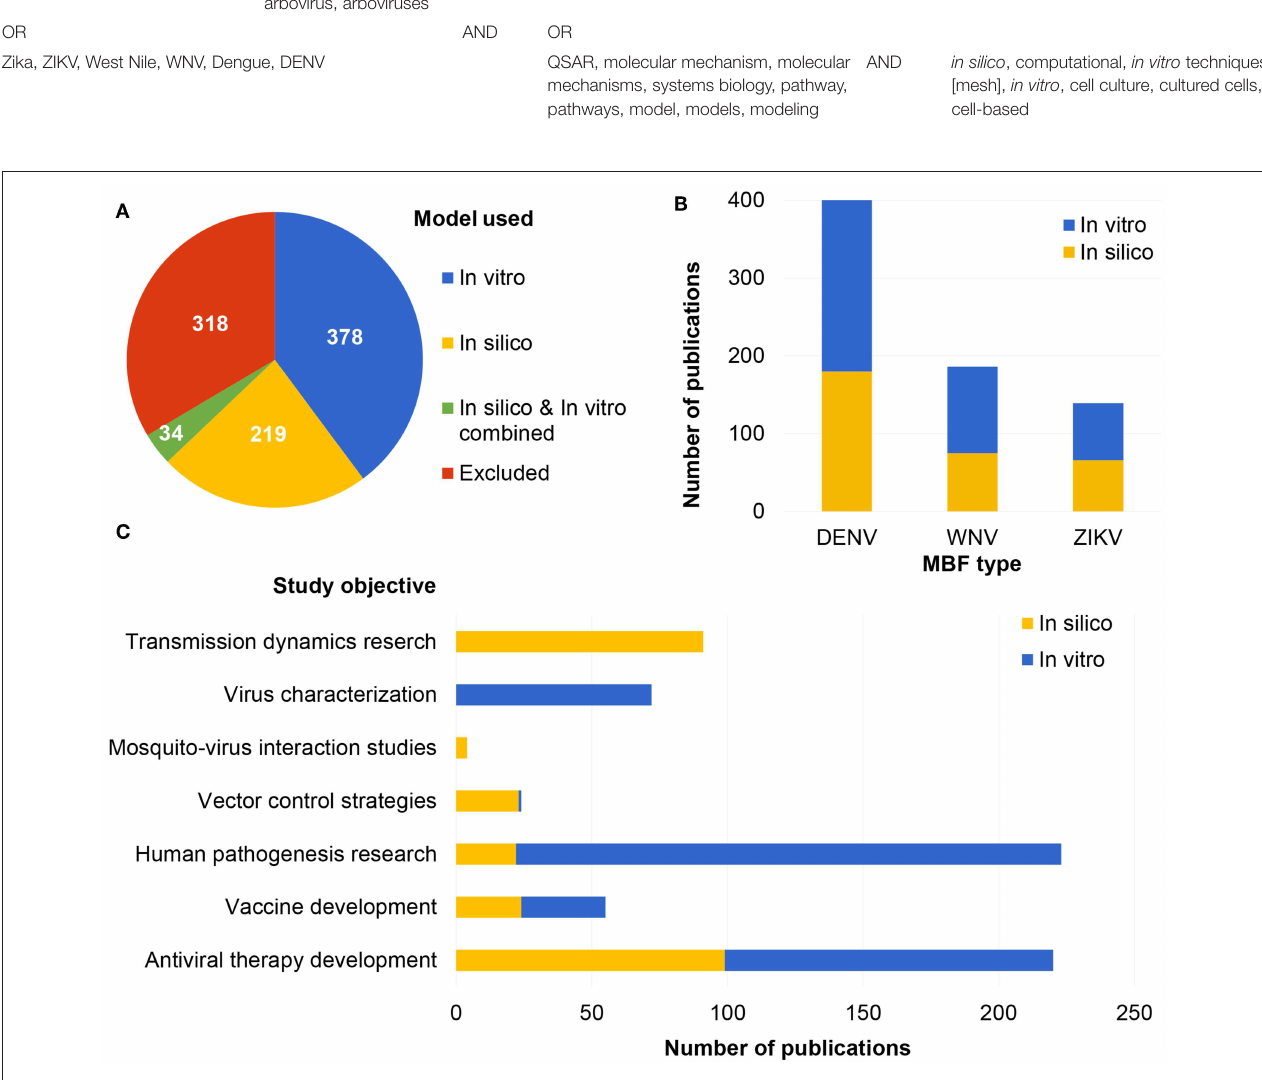
TABLE 1 | PubMed search query to identify in vitro and in silico studies. Flaviviridae, flavivirus, flaviviruses, flaviviral